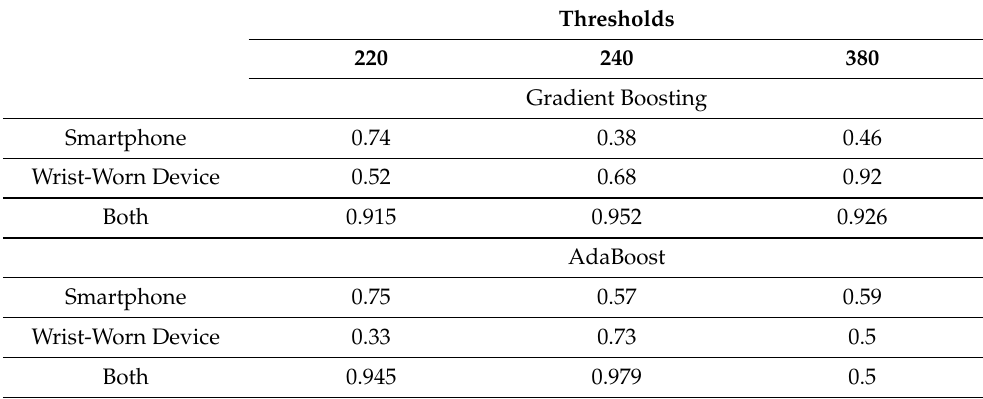
Table 7. AUC results of the AdaBoost and Gradient Boosting classifiers based on data obtained from a smartphone, wrist-worn device, and both devices.